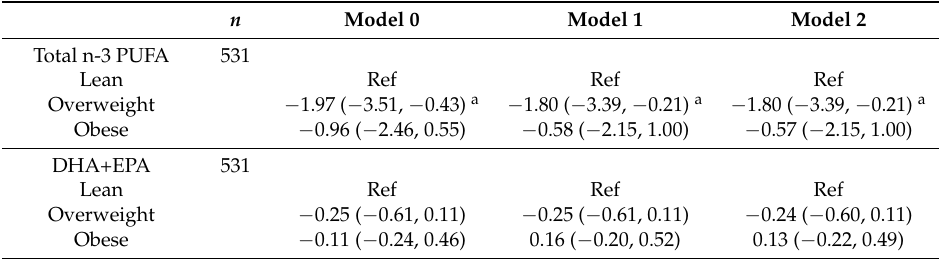
Table 3. Estimated difference ( β ) and 95% confidence interval in baseline PUFA concentrations between BMI